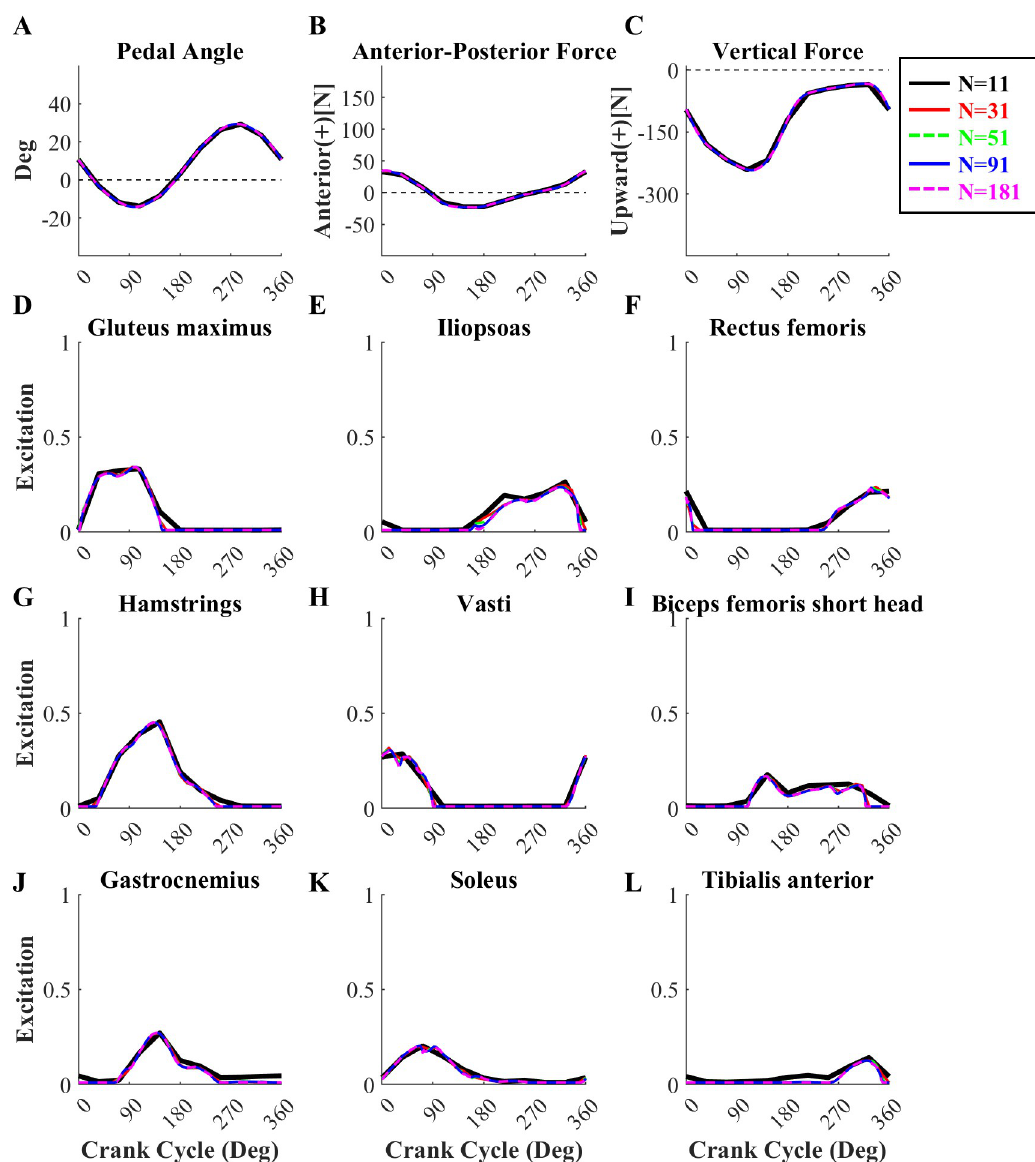
Fig 5. Simulated pedal angles, pedal forces, and MTU excitation patterns at each node. Simulated pedal angles (A), pedal forces (B-C), and MTU excitation patterns (D-L) obtained for simulations using 11 ( black solid line ), 31 ( red solid line ), 51 ( green dotted line ), 91 ( blue solid line ), and 181 ( magenta dotted line ) nodes compared with experimental pedal angles and forces ( dark gray dotted line , with gray shaded area representing ± 1 SD ). The optimal solution quality was similar for temporal node densities of 31 or greater.